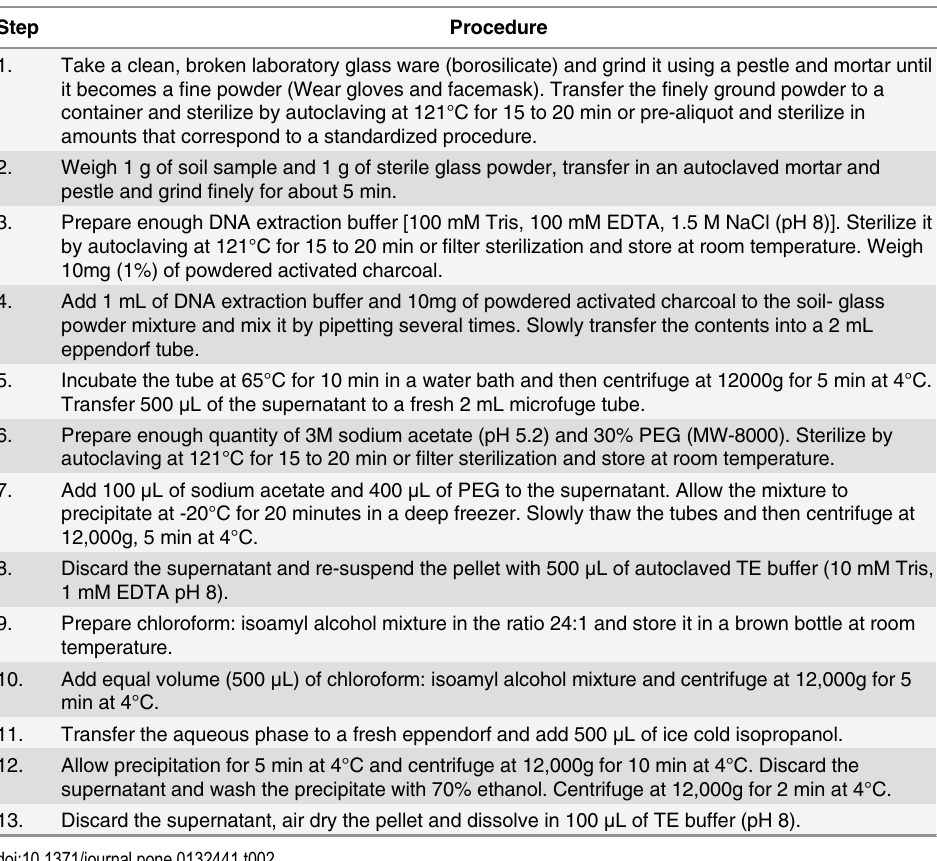
Table 2. Metagenomic DNA extraction from soils using the currently developed powdered glass method M6 modified from